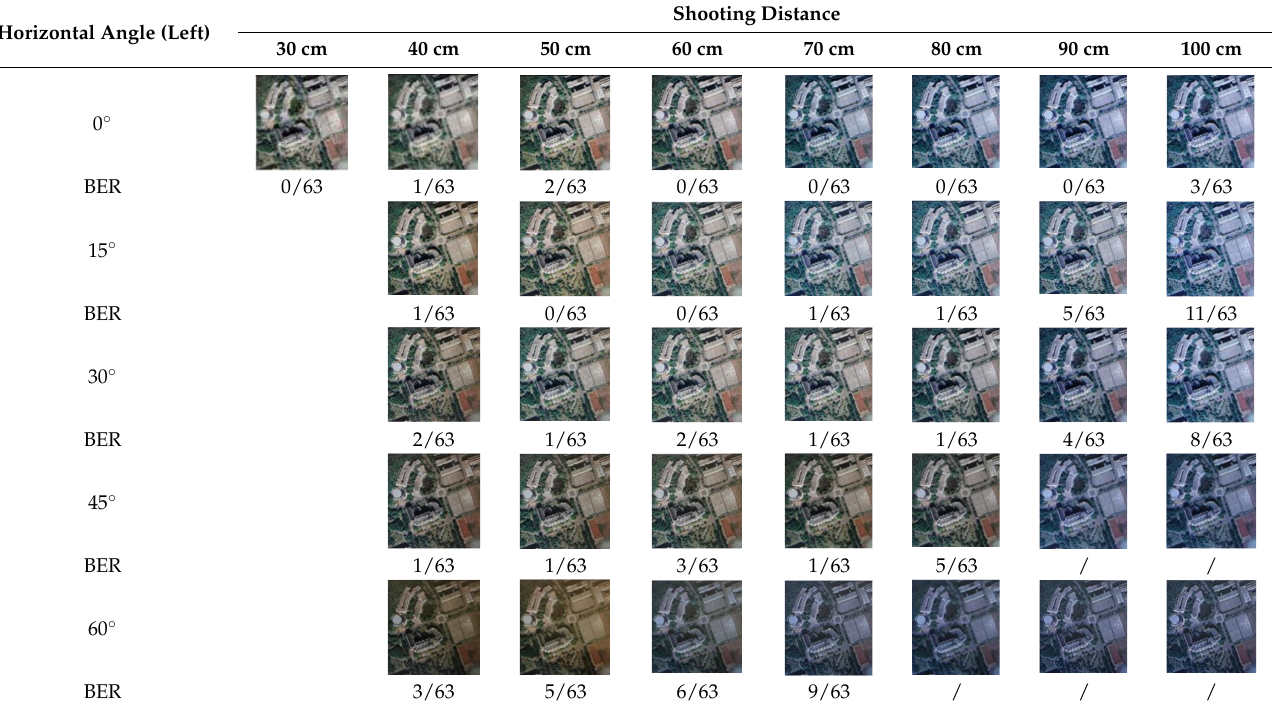
Table 10. Examples of NNU recovered from different captured